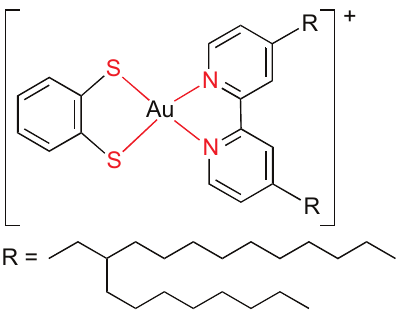
Figure 31. Bipyridine gold(III) liquid crystal.